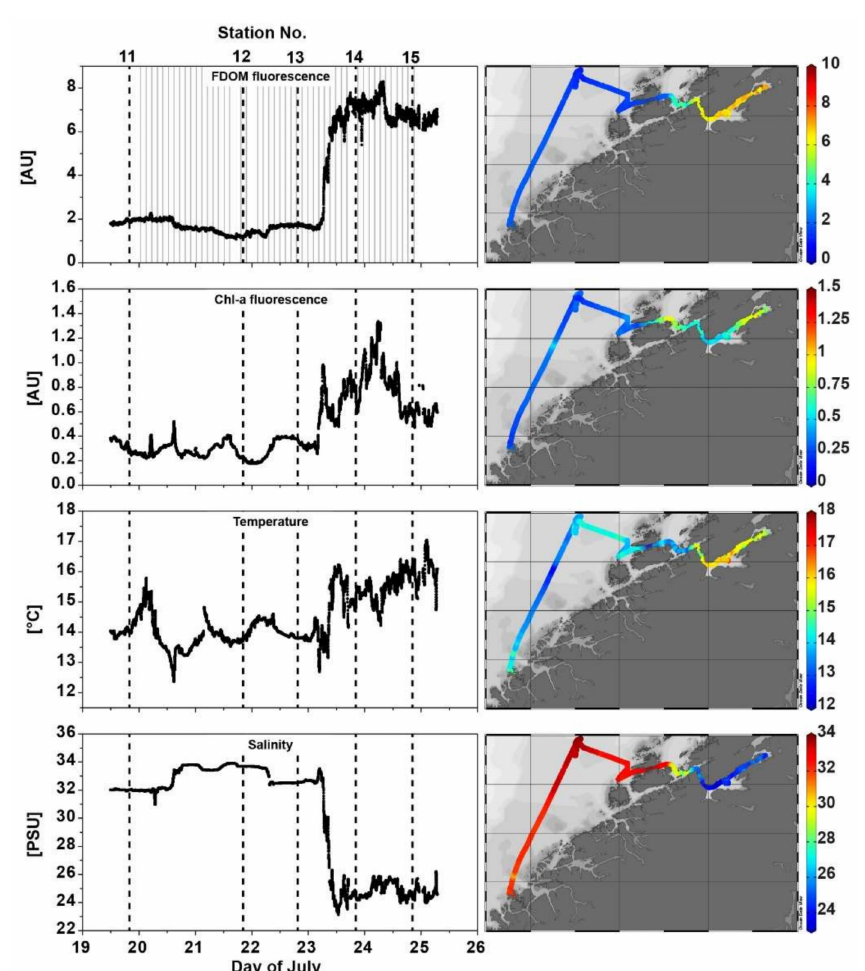
Figure 7. Underway oceanographic data measured by the FerryBox. From top to bottom: Fluorescent dissolved organic matter (FDOM) from the Cyclops-7-U bulk fluorometer, chlorophyll a fluorescence, temperature, and salinity. The left panels display the data as time series, the corresponding right ones as a map plot. Dashed lines indicate the stations where water samples were collected. Gray lines in the top-left panel indicate availability of the in situ Kallemeter-based EEM spectra (N = 48).